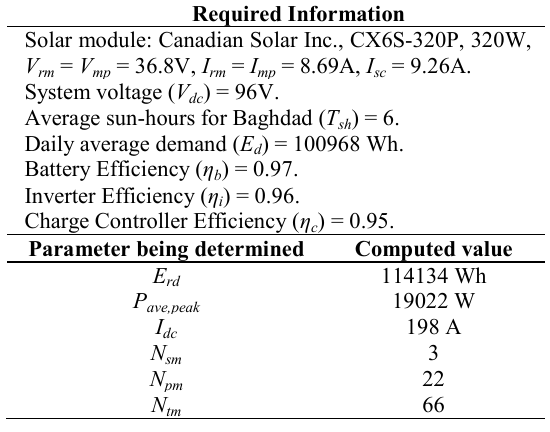
Table 5. Summary of PV array sizing.